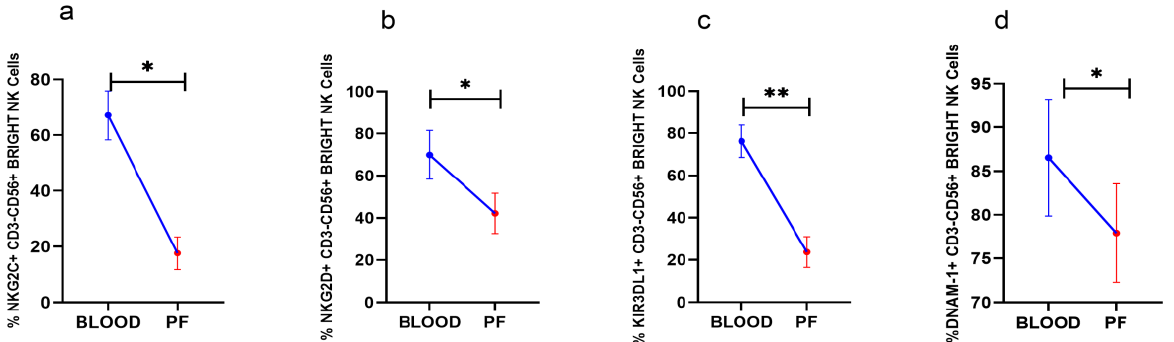
Figure 2. Wilcoxon matched-pairs signed ranked test ( a – d ) for receptor expression profile of CD56 Bright NK cells in peripheral blood and peritoneal fluid (PF) * p < 0.05; ** p < 0.01. 3.4. Improved Expression of Activating NKp46 on CD56 Dim NK Cells in Peritoneal